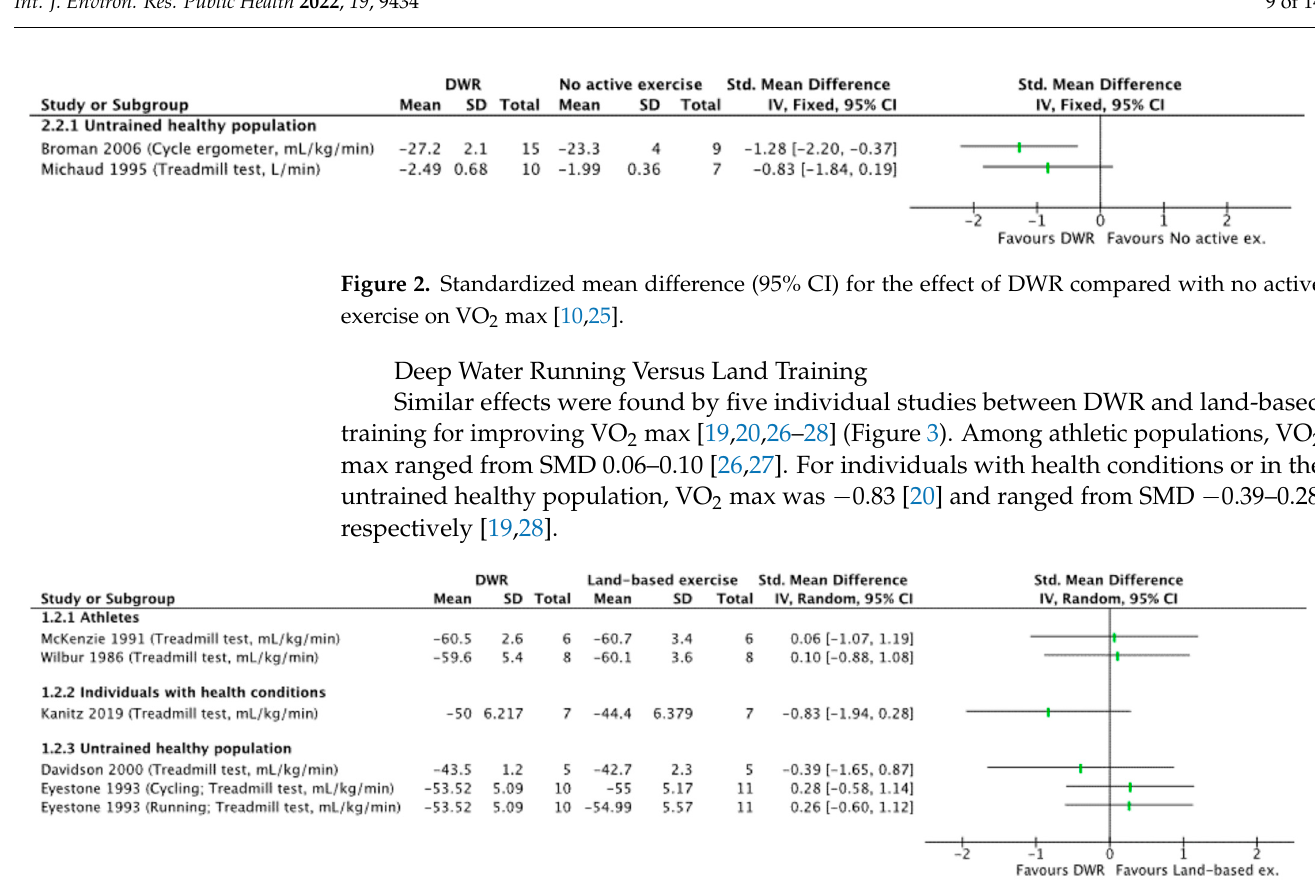
Figure 3. Standardized mean difference (95% CI) for the effect of DWR compared with land trainings on VO2 max [19,20,26–28].